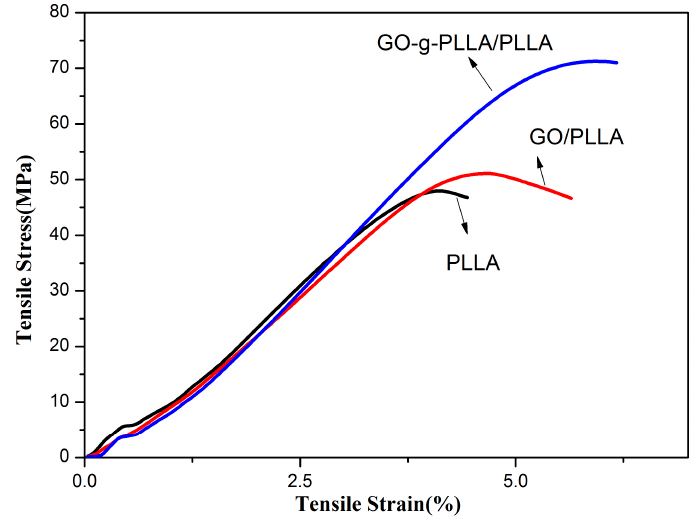
Figure 10. Stress-strain curves of PLLA, GO/PLLA, and GO- g -PLLA/PLLA.